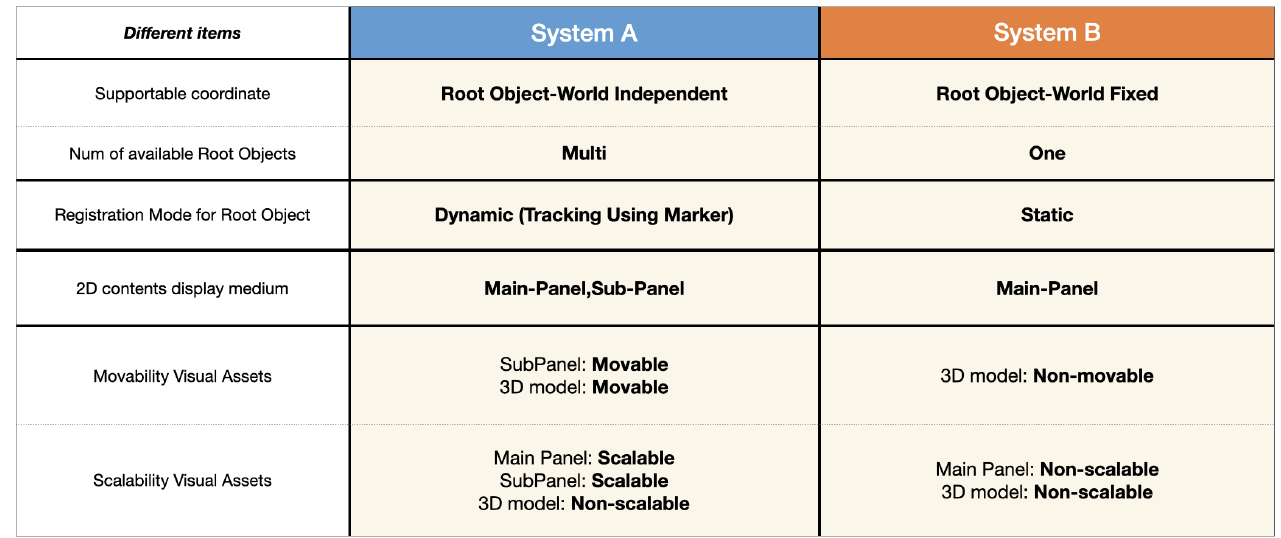
Figure 25. The differences between the two